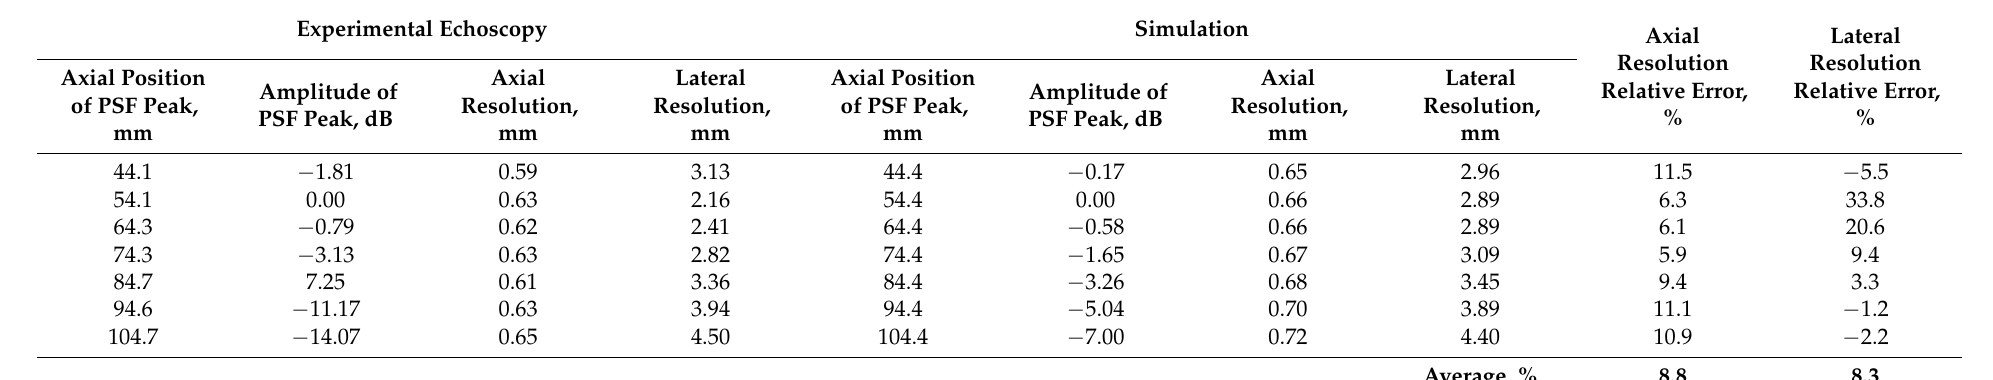
Table 2. FWHM parameter comparison of the experimental echoscopy of the physical wire phantom and simulation of wire phantom by wires. Experimental Echoscopy